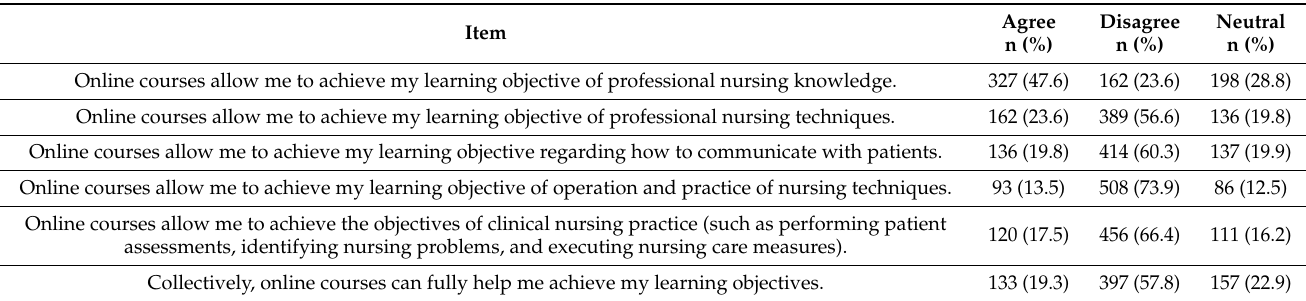
Table 4. Perspective on achieving the learning objective (n =